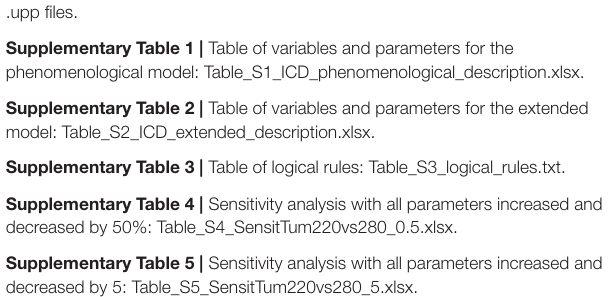
Frontiers in Physiology |